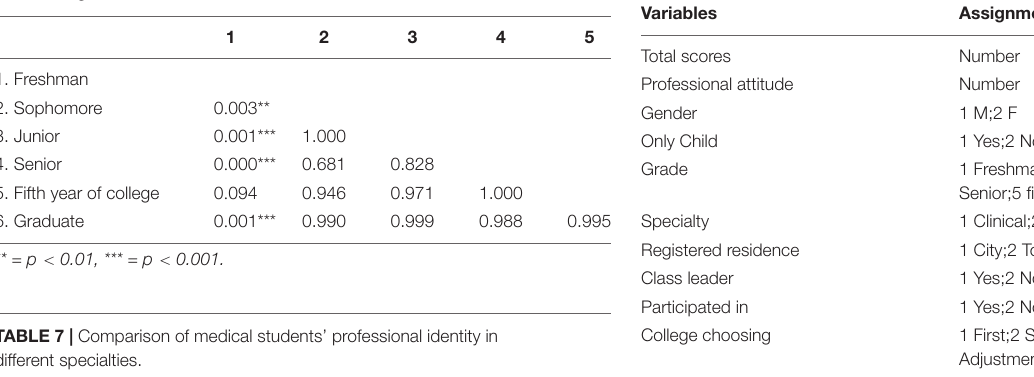
TABLE 6 | Multiple comparative analysis of medical students’ professional identity in different grades.